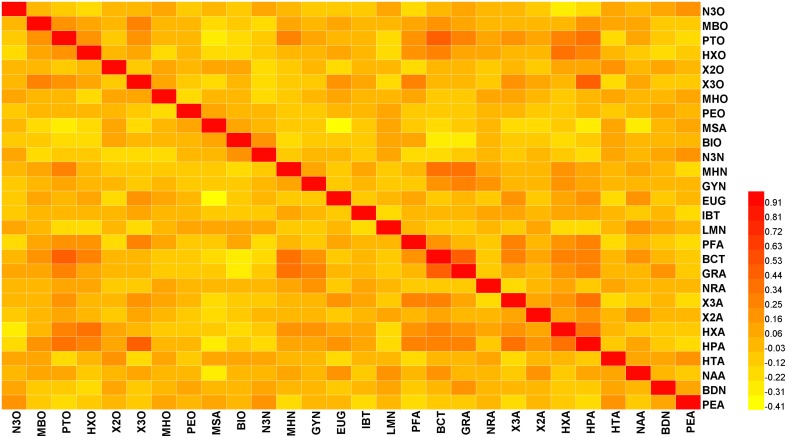
Heat map showing the correlation analysis between 28 volatiles in the 174 tomato accessions. Regions in red and yellow indicate positive or negative correlations between traits, respectively (The complete data is available in Table S2).